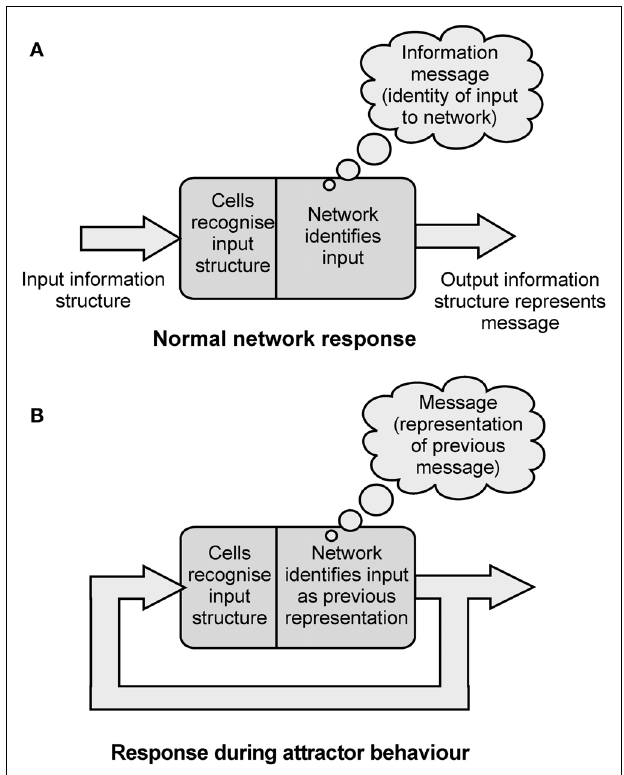
FIGURE 4 | (A) Diagram illustrating the way a network can recognize information structures, assign messages to them, and generate output information structures that represent the message assigned. (B) Diagram showing how in attractor behavior the network assigns a message of “representation of previous message” to it’s feedback